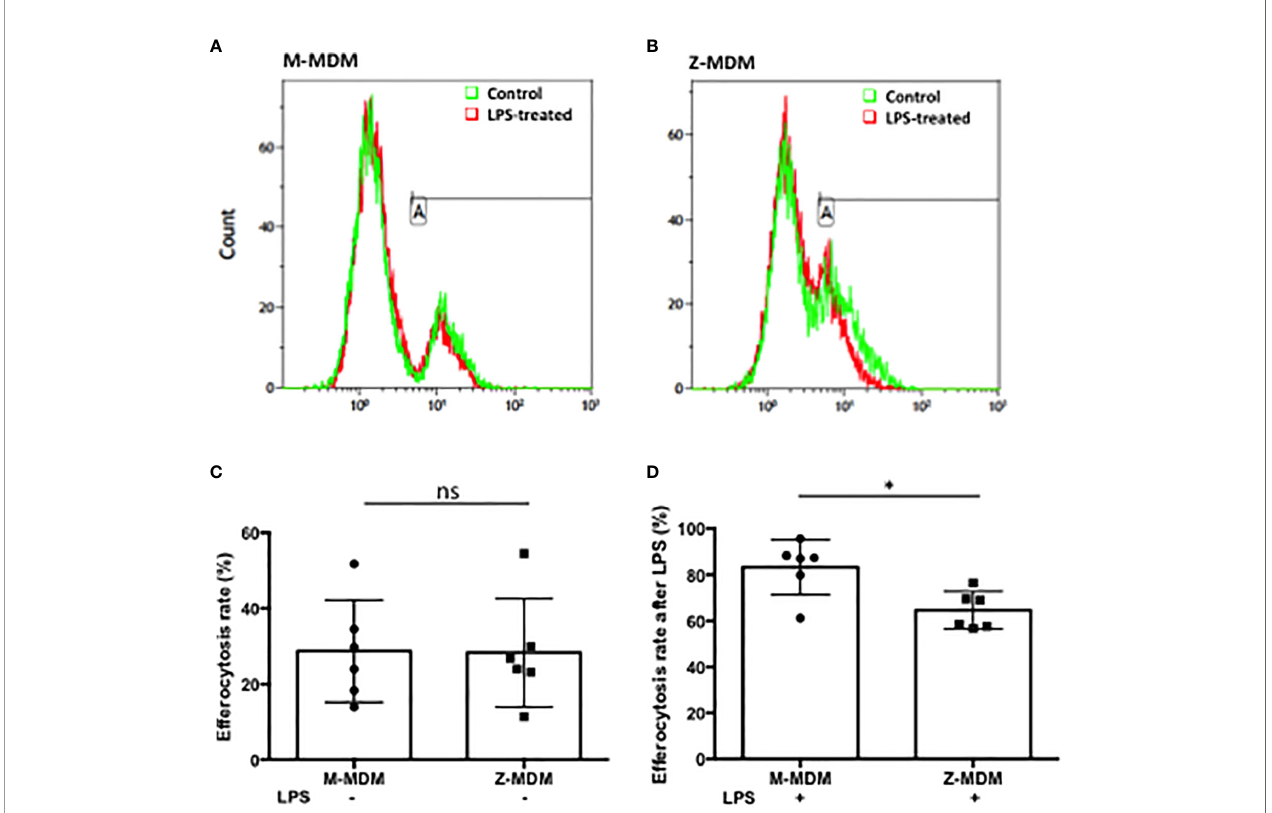
FIGURE 5 | Efferocytosis of apoptotic neutrophils by M- and Z-MDMs. MDMs were incubated with LPS (10 ng/ml) overnight and celltracker red-labeled apoptotic neutrophils were added to the MDM culture. Efferocytosis of the apoptotic cells by MDMs was assessed by fl ow cytometric analysis (A) M-MDM (B) Z-MDM. In each histogram plot, the green and red graphs indicate control and LPS-treated MDMs, respectively. The fi rst peak of the each graph indicates non-phagocytosing MDM population and the second peak indicates phagocytosing MDM population. (C) The efferocytosis rates of MDM controls were assessed by fl ow cytometric analysis; n=6. (D) Efferocytosis rates of LPS-treated MDMs are expressed relative to those of MDM controls that are set to 100%; n=6. *Denotes statistical signi fi cance (p-value < 0.05) according to two-tailed Student ’ s